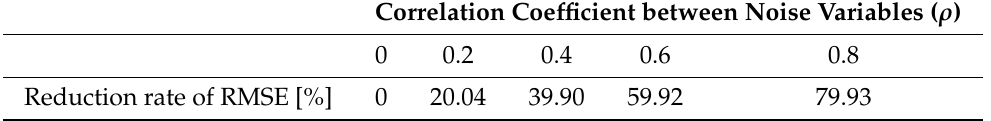
Table 1. Reduction rate of RMSE with increasing correlation coefficient between noise variables at high SNR and on-axis.